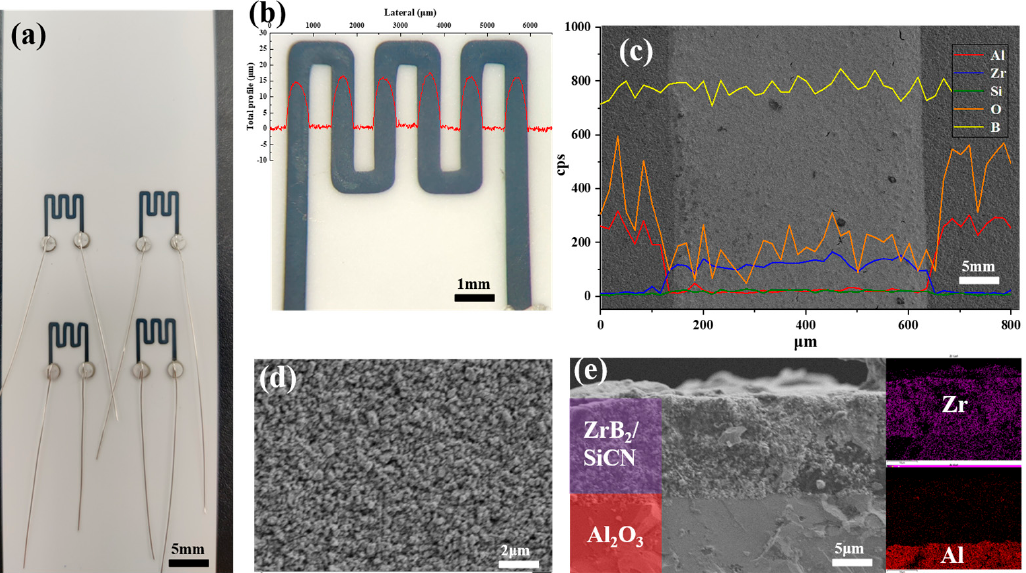
Figure 3. ( a ) Samples of the thin film strain gauge; ( b ) Thickness and width of strain grids; ( c ) Low-magnification SEM image and EDS analysis of TFSGs; ( d ) High-magnification SEM image of TFSGs; ( e ) The cross-sectional SEM images and EDS analysis of TFSGs.